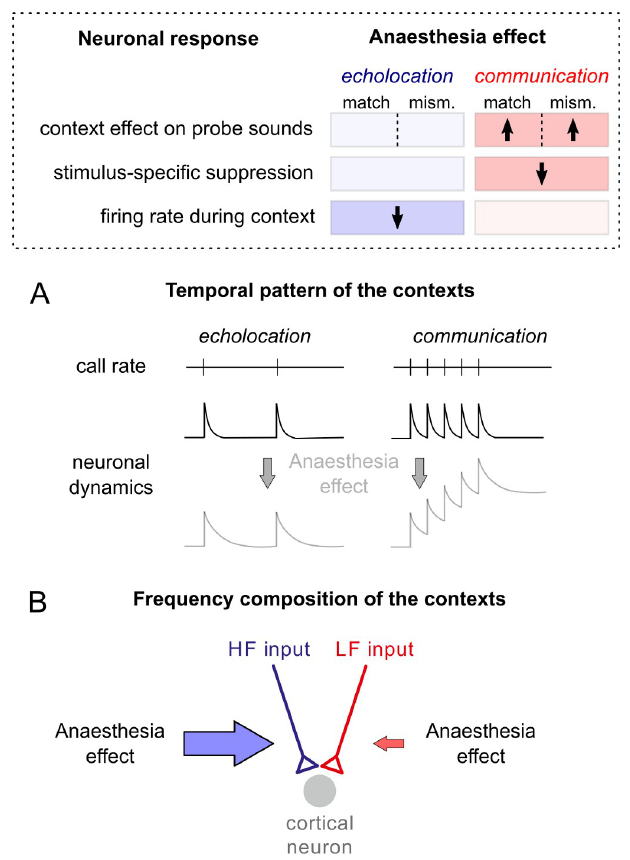
Fig 8. Anaesthesia modulates neuronal responses in an asymmetric manner for echolocation and communication context-probe paradigm. At the top, a summary of the experimental results. Direction of the significant changes is indicated with arrows on three different results regarding context-probe paradigm. Note that the changes occur in an asymmetrically between contexts, which can be explained either by ( A ) differences in the temporal pattern of the contexts or ( B ) differences in the frequency composition of the